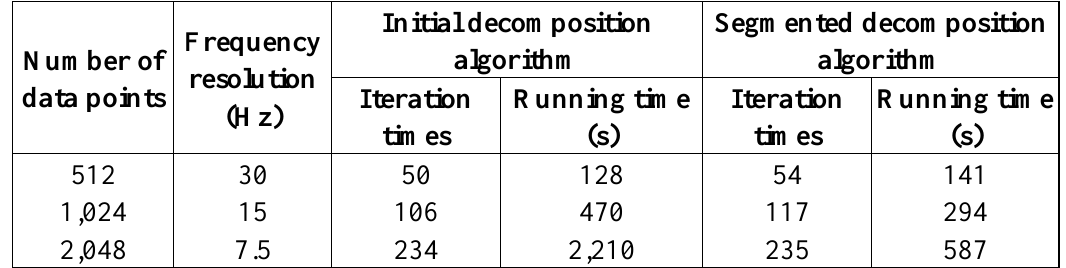
Table 3. Comparison of iteration times and running time of initial algorithm and improved algorithm.